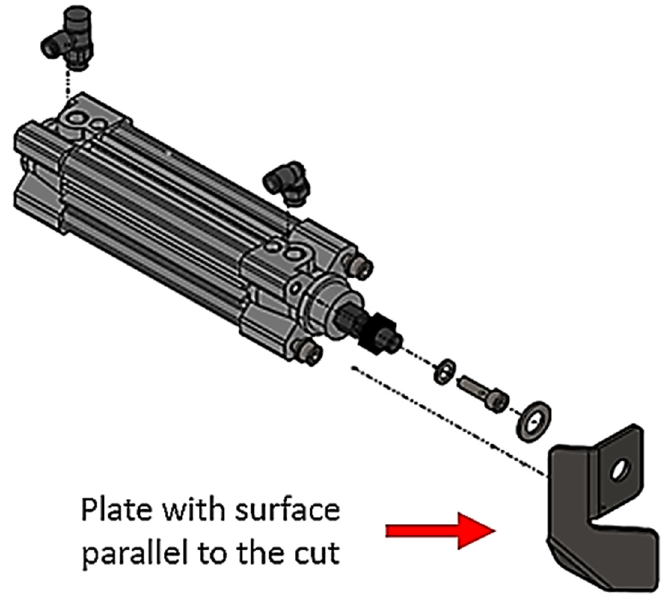
Figure 22. Handle sub-assembly’s exploded view.